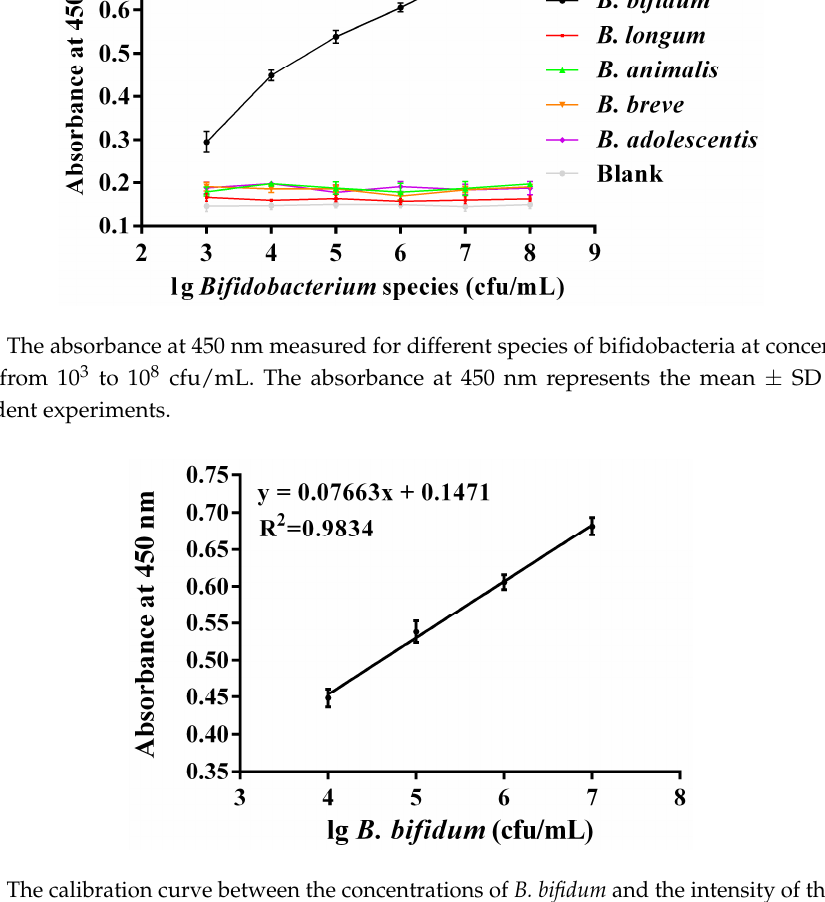
Figure 7. The calibration curve between the concentrations of B. bifidum and the intensity of the signals. The OD values were determined by the microplate reader at 450 nm wavelength. The absorbance at 450 nm represents the mean ± SD of three independent experiments.